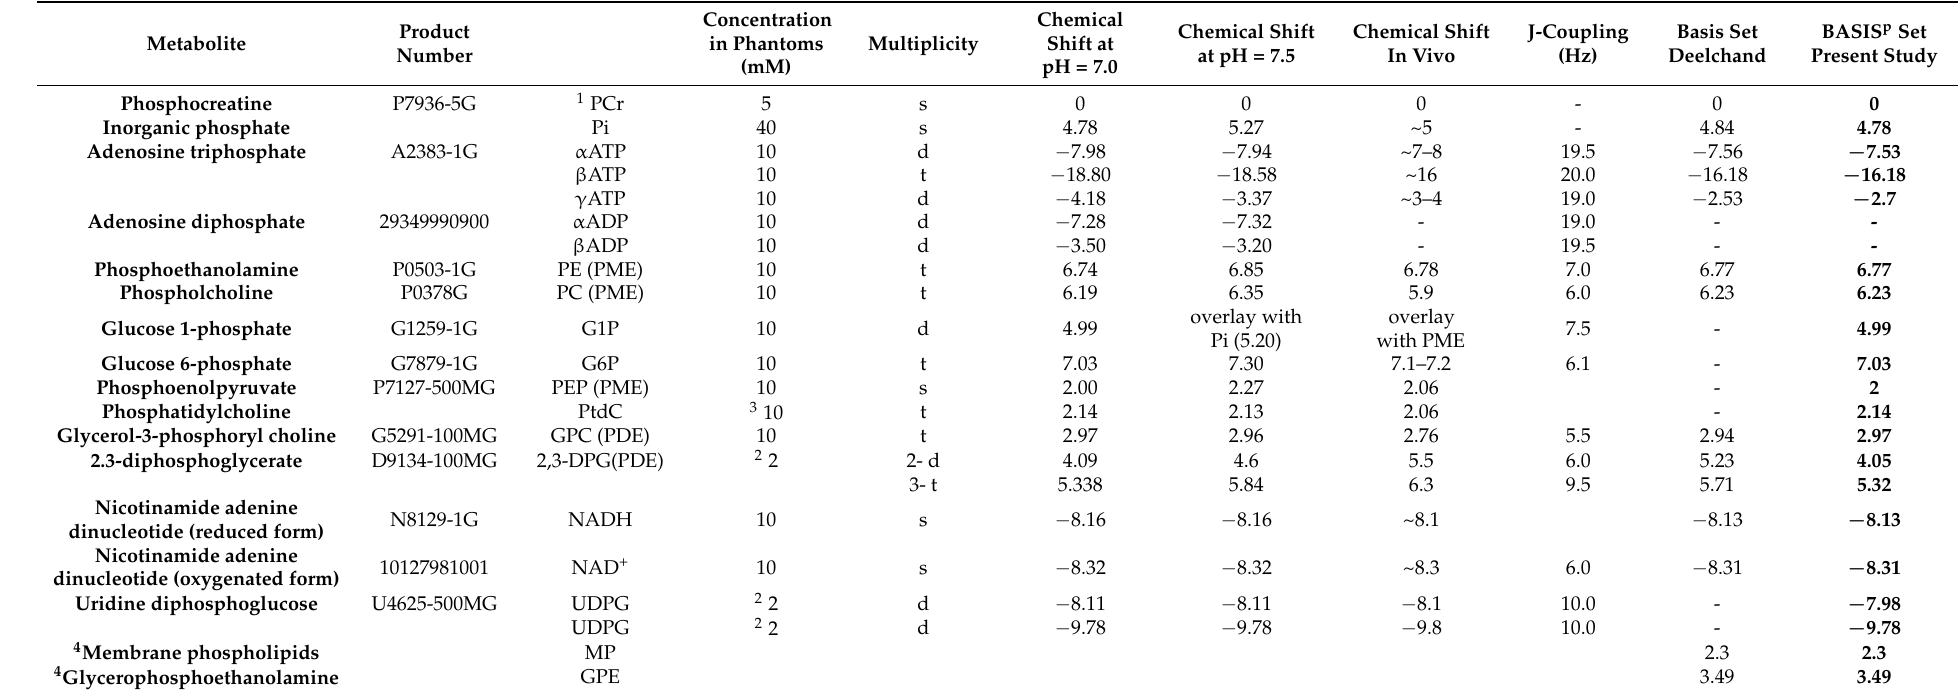
Table 1. Concentration of 31 P MR phantoms, their chemical shifts (ppm) and coupling